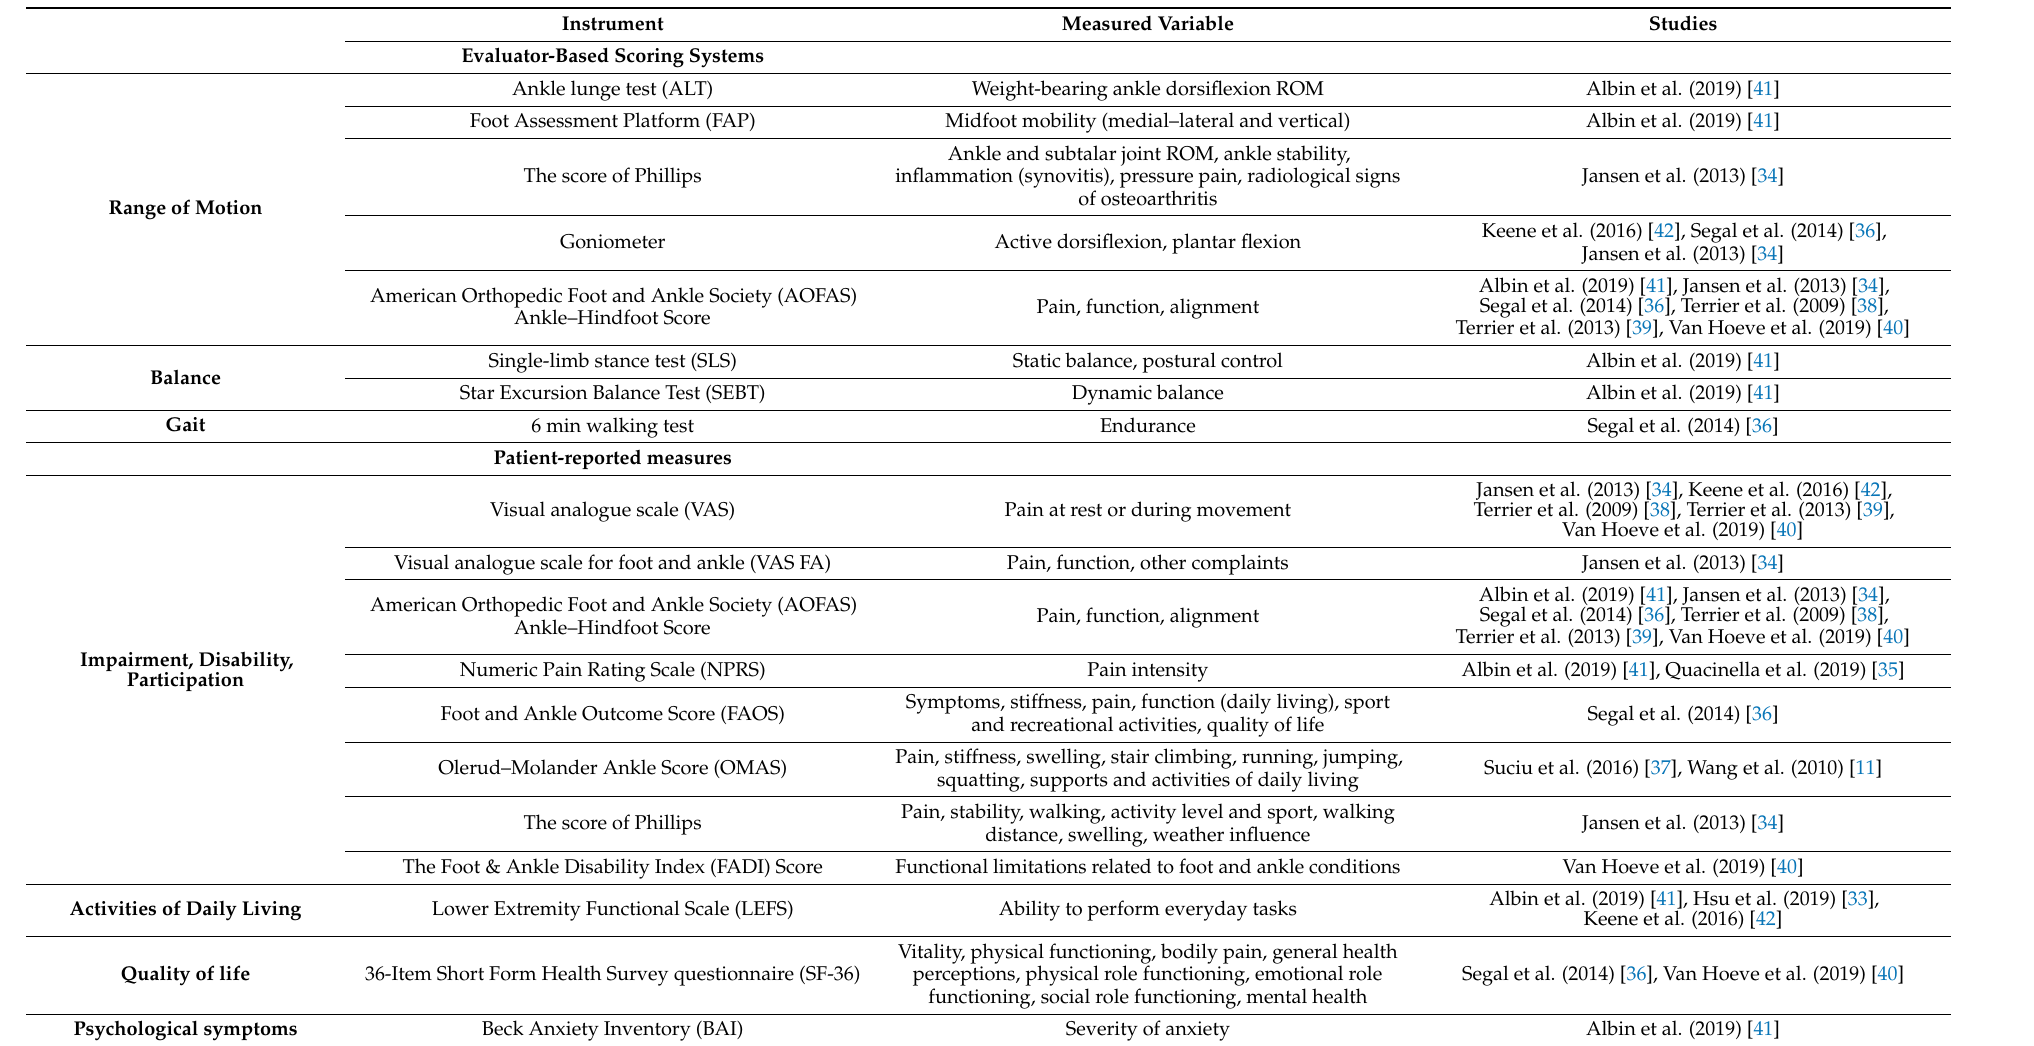
Table 4. List of domains and relative clinical outcome measures evaluated in the selected